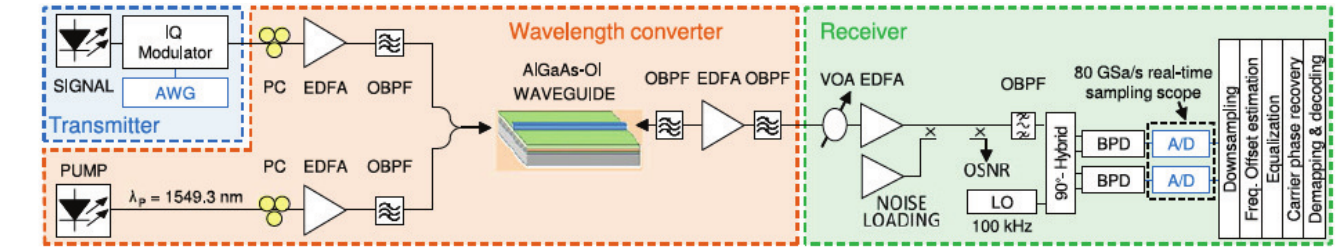
Figure 15. Schematic of the experimental setup of 256-QAM transmitter, AlGaAs-OI wavelength converter, and receiver. ©2017 IEEE. Reprinted, with permission, from [139].